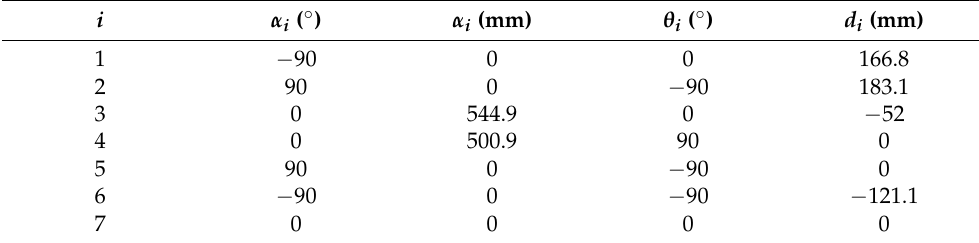
Figure 4. Space manipulator and its coordinate systems. Table 1. Kinematic parameters of the space manipulator.